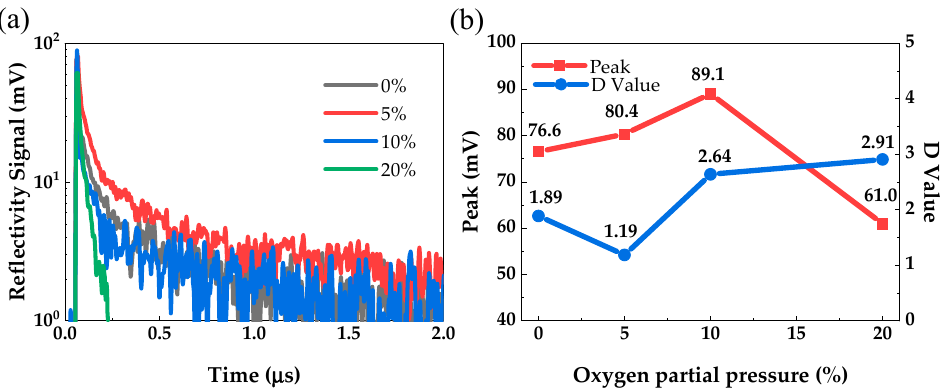
Figure 7. The microwave photoconductivity decay (µ-PCD) results of PrIZO thin films: ( a ) the µ-PCD curves, ( b ) peak and D value. curves, ( b ) peak and D value.